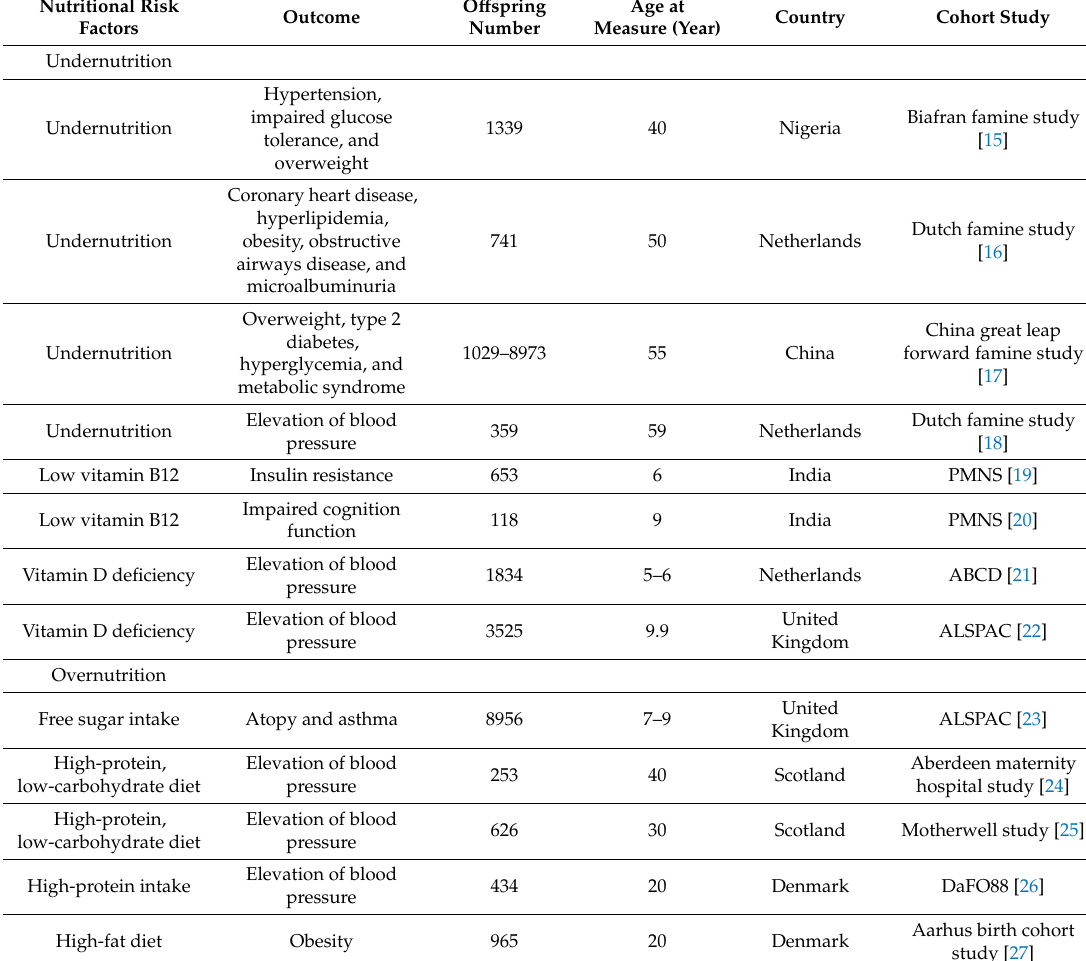
E ff ects of malnutrition during pregnancy on adverse o ff spring outcomes in human cohort